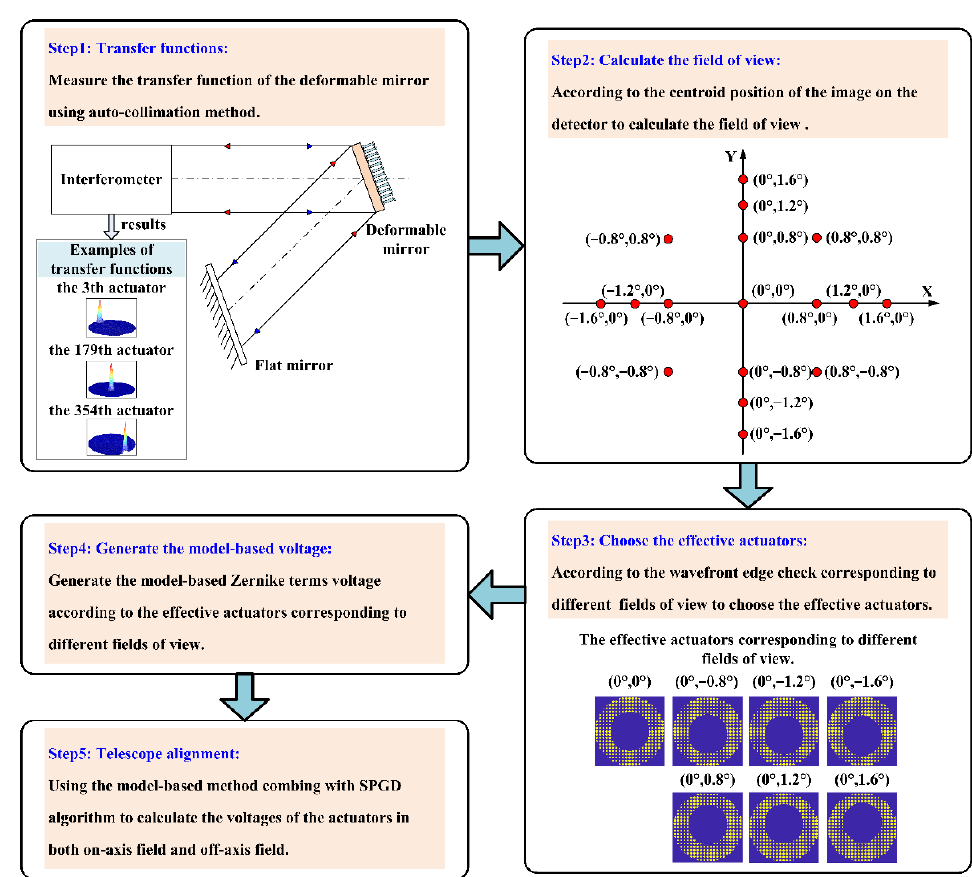
Figure 4. Calculation principles of transfer functions corresponding to different fields of view.